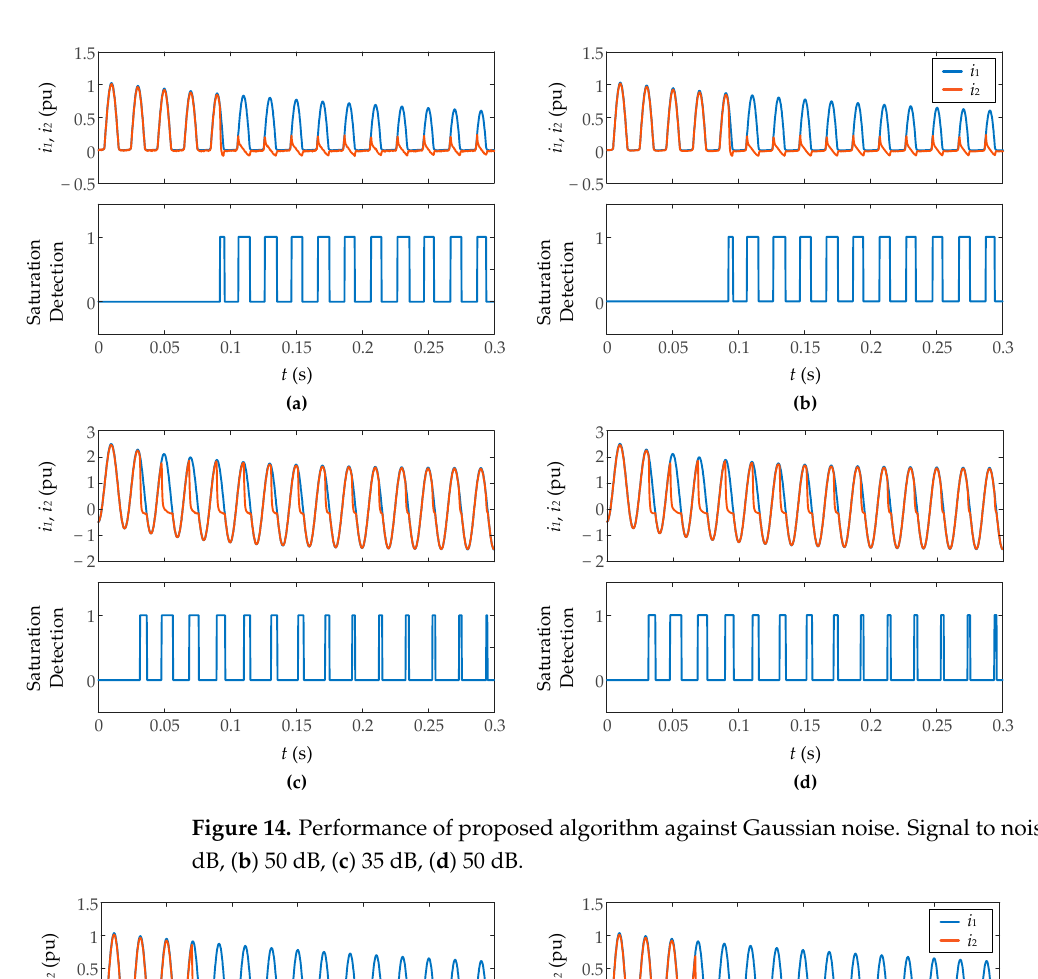
Figure 13. Performance of proposed algorithm on fault currents for different resistive CT burdens: